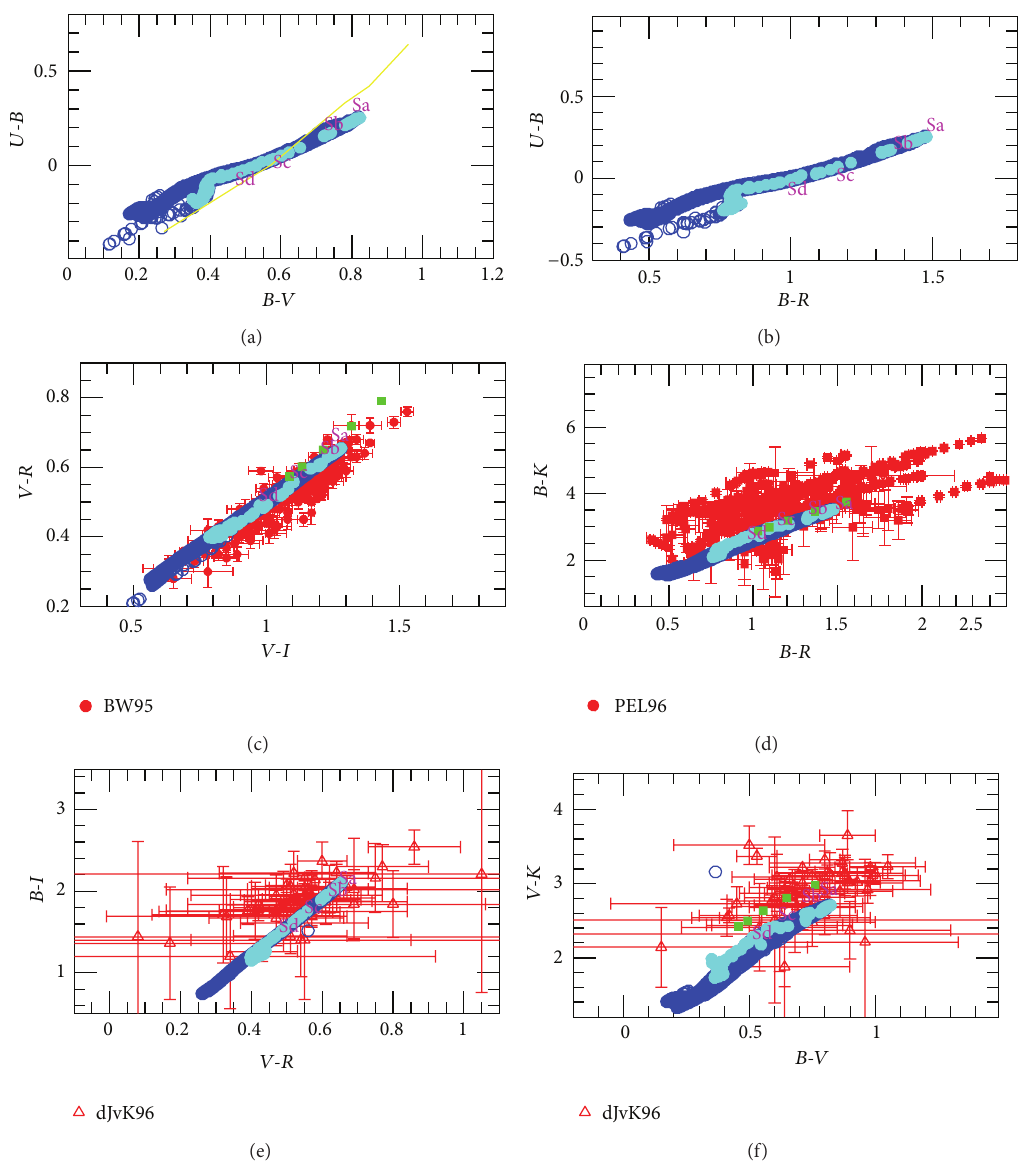
Figure 11: Color-color diagrams. Colors 𝑈 - 𝐵 versus 𝐵 - 𝑉 , 𝑈 - 𝐵 versus 𝐵 - 𝑅 , 𝑉 - 𝑅 versus 𝑉 - 𝐼 , 𝐵 - 𝐾 versus 𝐵 - 𝑅 , 𝐵 - 𝐼 versus 𝑉 - 𝑅 , and 𝑉 - 𝐾 versus 𝐵 - 𝑉 are represented as blue dots and compared with observational data. The standard values for typical galaxies along the Hubble sequence as Sa, Sb, Sc, and Sd are taken from Poggianti [132] and shown as in magenta letters. In the panel 𝑈 - 𝐵 versus 𝐵 - 𝑉 , the yellow line corresponds to data from Vitores et al. [133], the red dots are from Buta and Williams ([129], BW95) in 𝑉 - 𝑅 versus 𝑉 - 𝐼 , from Peletier and Balcells ([130], PEL96) in panel 𝐵 - 𝐾 versus 𝐵 - 𝑅 , and from de Jong ([131], dJvK96) in 𝐵 - 𝐼 versus 𝑉 - 𝑅 and 𝑉 - 𝐾 versus 𝐵 - 𝑉 panels The green full squares are from